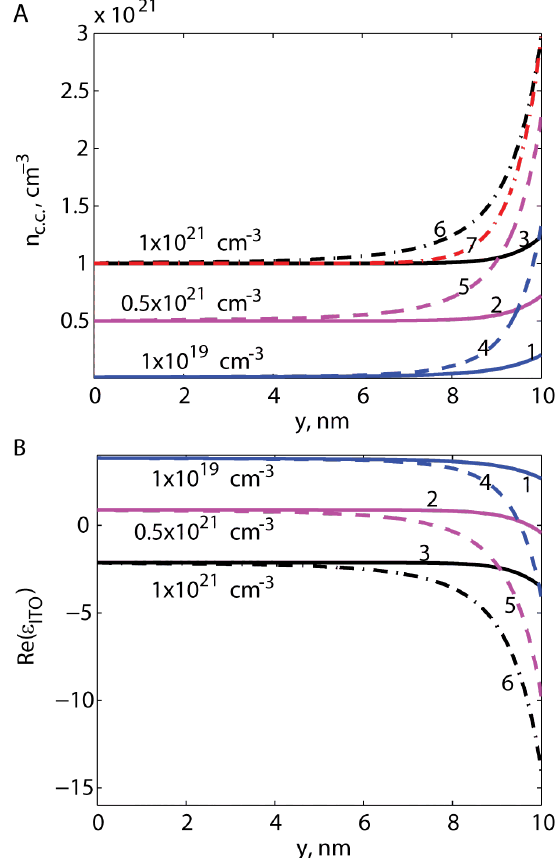
Figure 7: Change of carrier concentration (A) and TCO permittivity (B) according to the Thomas–Fermi screening theory. 2.5 V per 5- nm thick SiO 2 or HfO 2 layer was taken for the calculations. 10 19 , 5 × 10 20 , and 10 21 cm −3 correspond to different initial concentration of carriers in the TCO layer. Solid curves 1, 2, and 3 correspond to SiO 2 and dashed curves 4, 5, and 6 correspond to HfO 2 . In (A), curve 7 shows approximation with the exponential decay defined by the Thomas–Fermi screening length. TCO: Transparent conducting